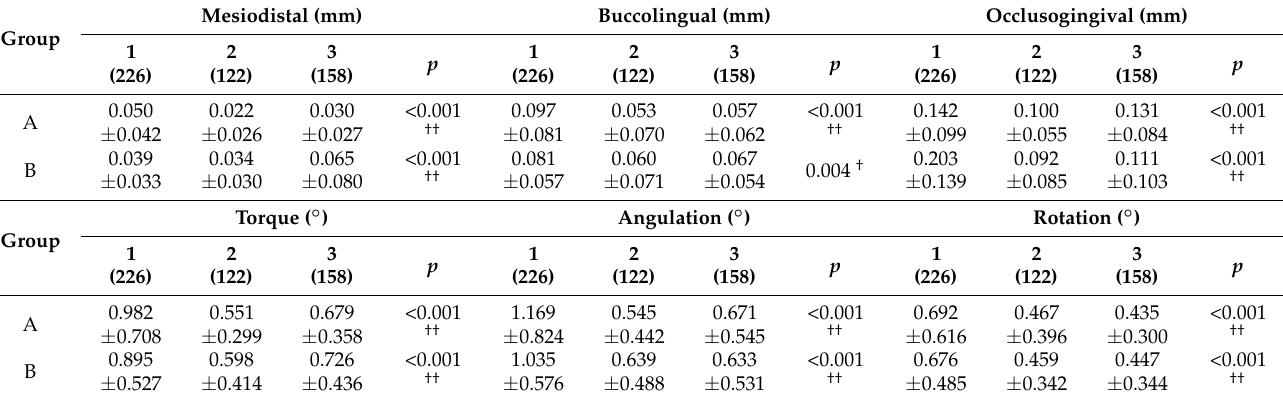
Table 3. Comparison according to the tooth type for each experimental group.